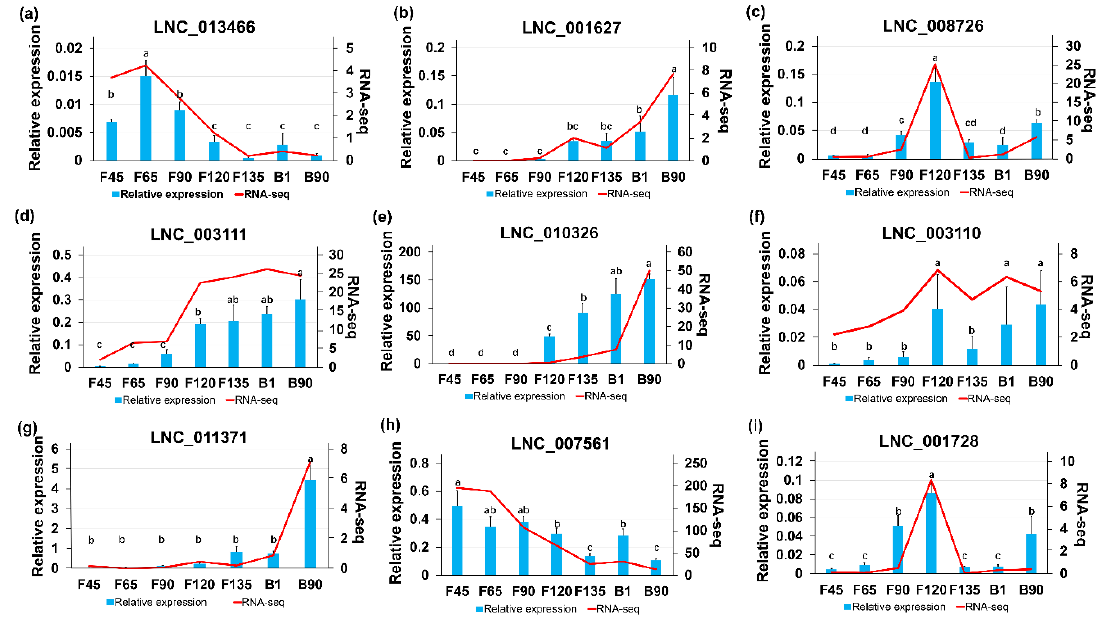
Figure 8. Validation of six differentially expressed lncRNAs by qPCR and RNA-seq. ( a–i ) qPCR (bar chart, blue) and RNA-seq expression (line chart, red) validation of the indicated lncRNAs in modules. The letters on the column diagram indicate significant ( p < 0.05) differences at different stages.